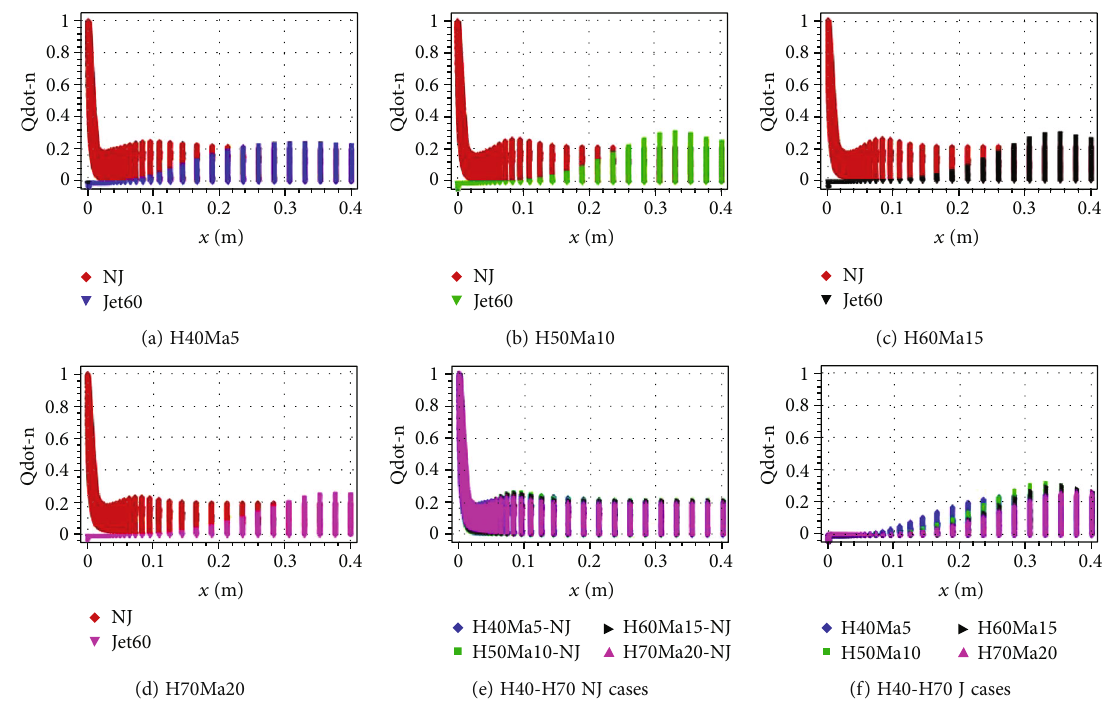
Figure 11: Comparison of the _ QN values from the NJ and J cases under di ff erent fl ight conditions and di ff erent heights.